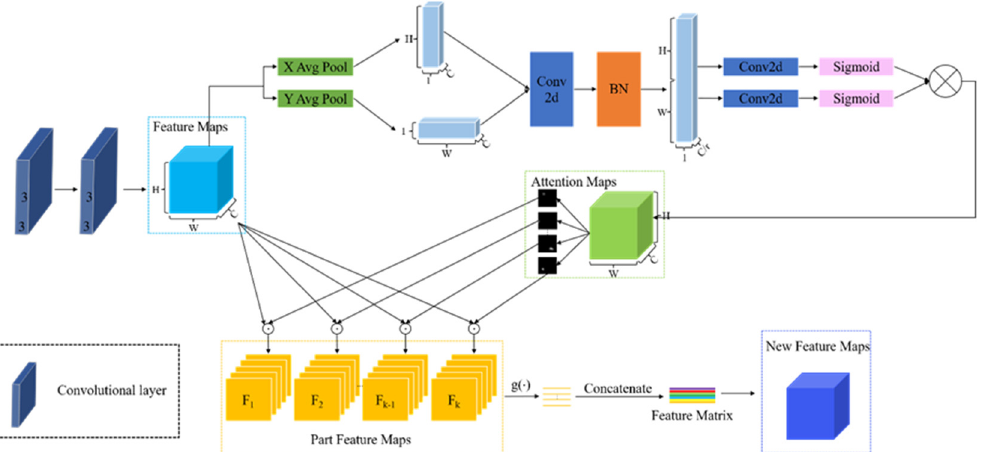
Figure 2. Dual bilinear attention module—DBAM, where ⊙ denotes the element-by-element multiplication of two tensors, g ( ﹒ ) is a feature extraction function, W , H , and C denote width, height, and channel size.